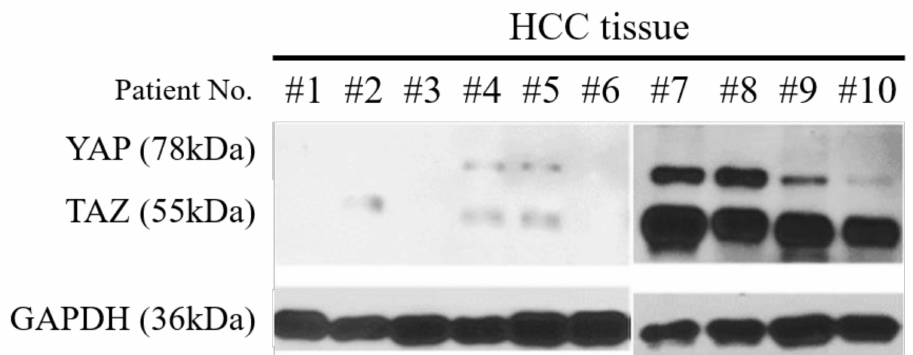
Figure 2. Western blot showing YAP/TAZ expression among HCC tissue. Lysates of HCC tissue were analyzed by Western blotting with anti-YAP/TAZ and anti-GAPDH (control) antibodies. For the original Western blots, see Supplementary Figure S1.